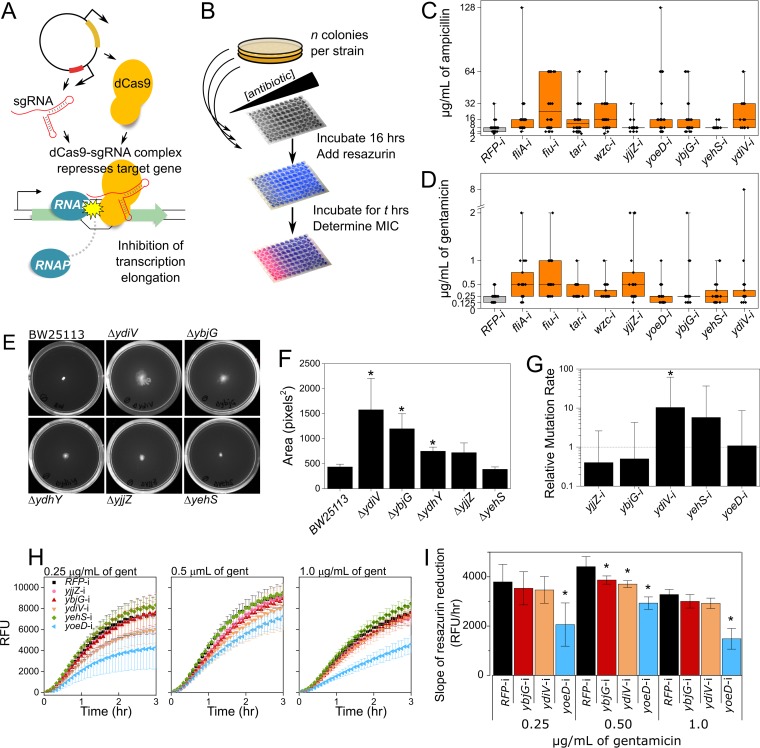
Synthetic perturbation of DE and DV genes. (A) CRISPR interference (CRISPRi) is used to repress gene expression by blocking progression of RNA polymerase (RNAP) at a site specified by the sequence of the sgRNA. The dCas9 protein and the sgRNA are expressed from a medium-copy-number plasmid. (B) MIC was determined for individual colonies from each CRISPRi strain. Colonies were grown for 16 h in a range of antibiotic concentrations, and MIC was determined visually through a resazurin assay. (C and D) The MICs of ampicillin (C) and gentamicin (D) are shown for individual colonies from each CRISPRi strain. Box plots show the interquartile range. The median is marked with a horizontal line. Whiskers demarcate minimum and maximum values. Individual data points are overlaid on the box plots. n = 19 to 50 colonies per strain. (E) Representative plates from swarming motility assay, for E. coli BW25113 wild-type and five knockout strains after 48 h of growth. (F) Average area from swarming motility assay. Error bars represent the standard deviation across n = 3 replicates per strain. (G) Relative mutation rates for CRISPRi strains (rate of strain/rate of RFP-i control). Error bars represent the standard deviation (n = 30 parallel cultures for each). (H) Resazurin reduction curves. RFU, relative florescence units. Error bars are the standard deviation (n = 4 replicates). gent, gentamicin. (I) Slopes of resazurin reduction curves in panel H. For panels F, G, and I, asterisks indicate a result significantly different from the control (P < 0.05).